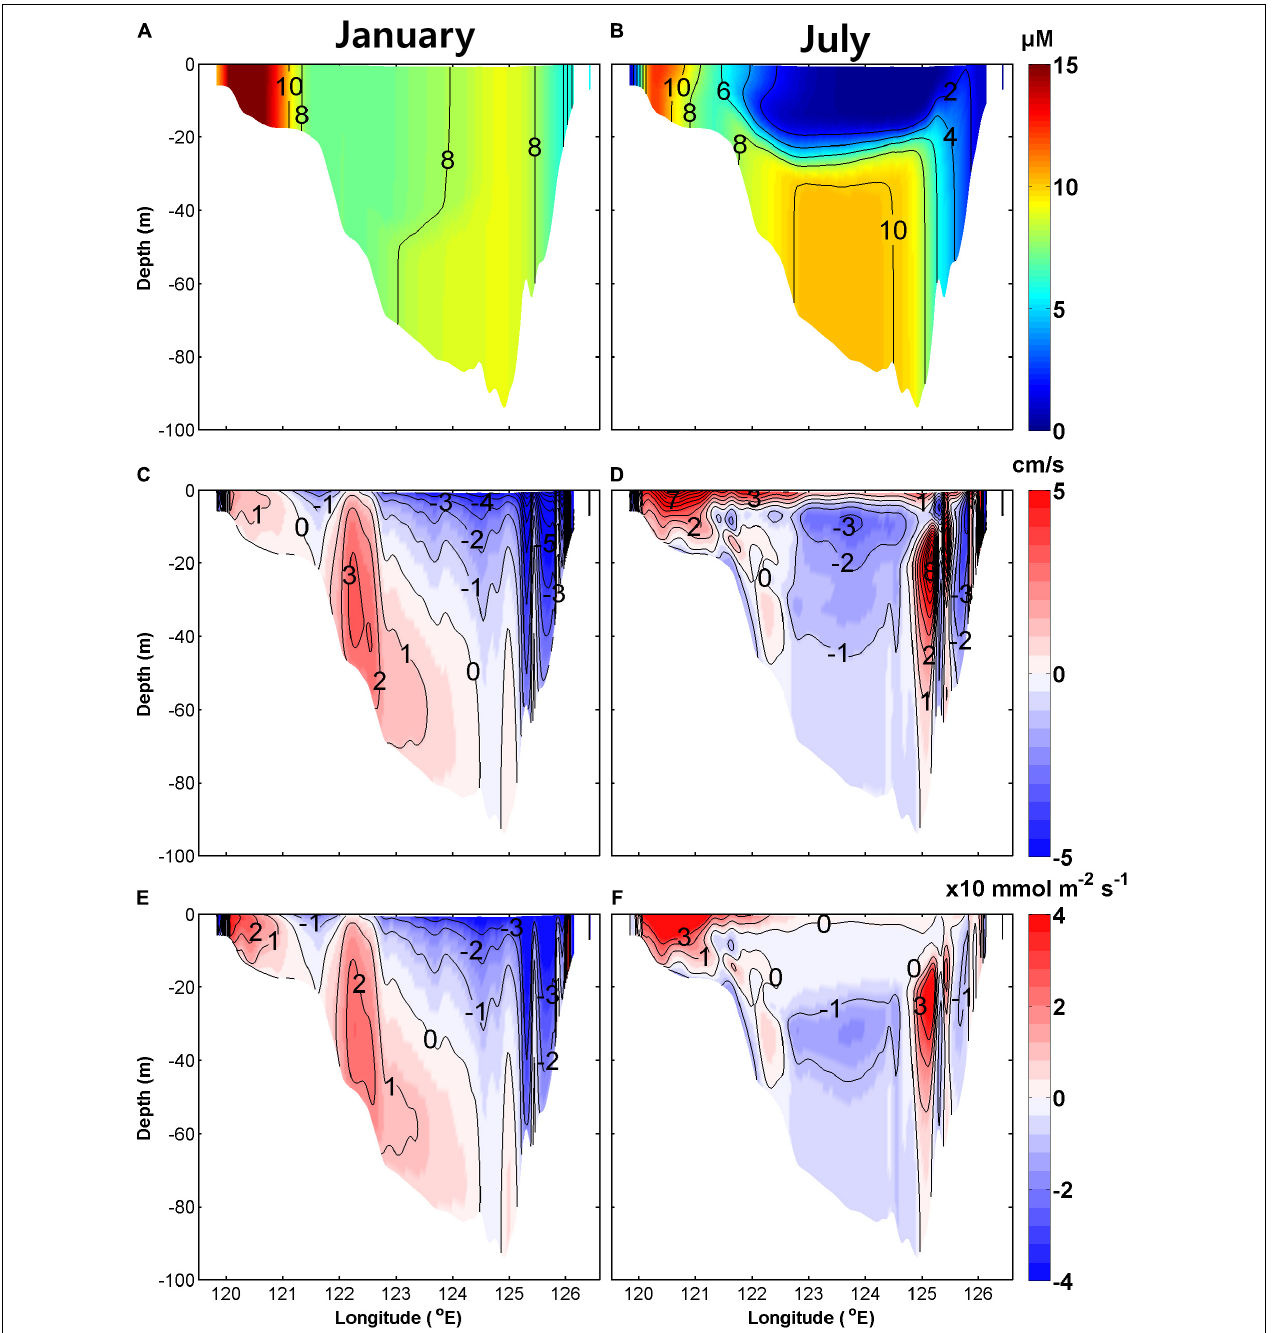
FIGURE 10 | Climatological monthly mean vertical sections of NO 3 − concentration (upper), meridional velocity (middle), and NO 3 − flux (lower) along the 34.5 ◦ N section in January (A,C,E) and July (B,D,F) averaged for the period 2006–2019. Colors in upper panels indicate NO 3 − concentrations ( µ mol L − 1 ). Red and blue in middle and lower panels indicate northward and southward velocities (cm/s) and NO 3 fluxes ( × 10 mmol m − 2 s − 1 ), respectively.